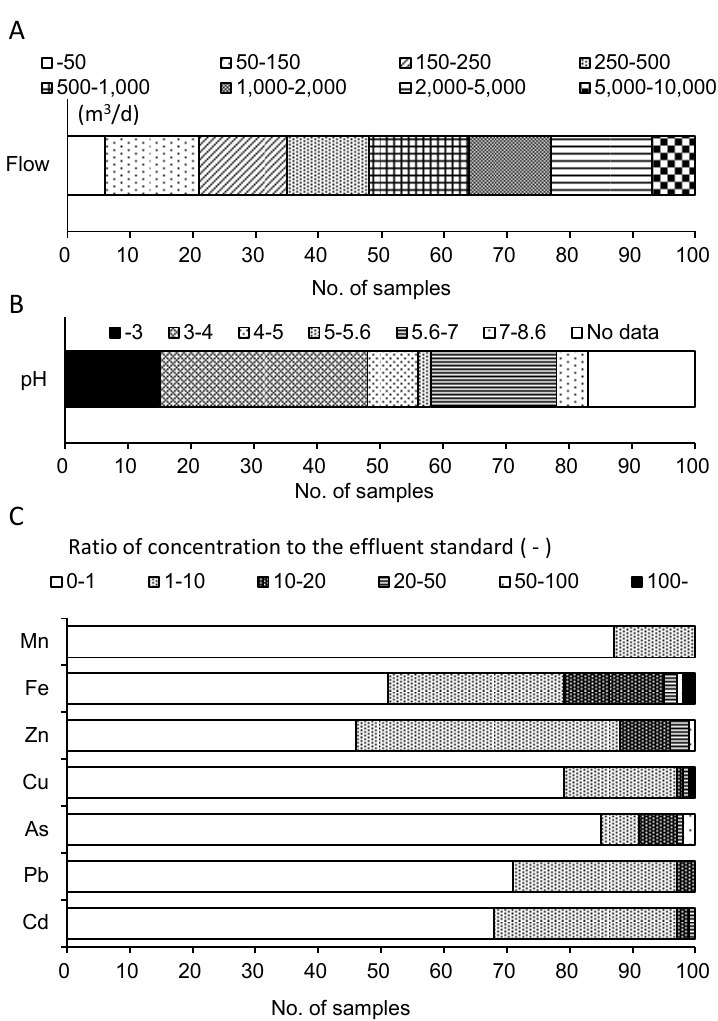
Figure 2. Average characteristics of 100 mine drainages in Japan (2014–2016). Flow rate ( A ), pH ( B ), and ratio of metal concentration to the effluent standard in Japan (Cd: 0.03 mg/L, Pb: 0.1 mg/L, As: 0.1 mg/L, Cu: 3 mg/L, Zn: 2 mg/L, soluble Fe: 10 mg/L, and soluble Mn: 10 mg/L) ( C ).